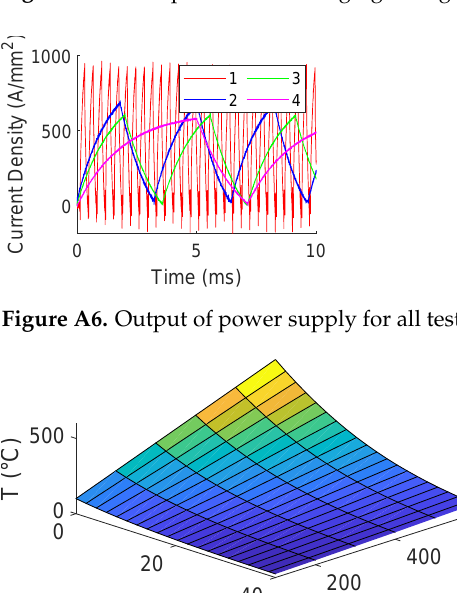
Figure A5. Example effect of changing voltage on power supply output.